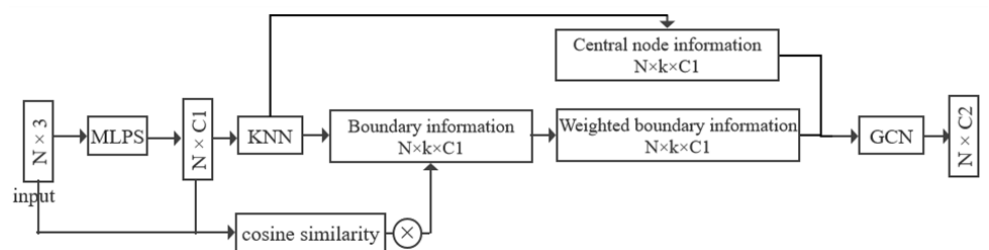
Figure 8. GCN with boundary weighting is used as the feature extraction